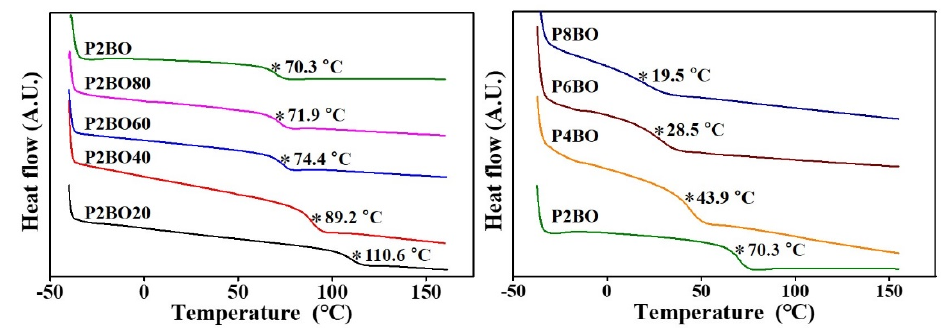
Figure 3. Differential scanning calorimetry (DSC) thermogram of P2BO# (P2BO20, P2BO40, P2BO60, and P2BO80) and PABO (P2BO, P4BO, P6BO, and P8BO) (* indicates the glass transition). Table 1. Reaction conditions and results for the synthesis of the P2BO# and PABO (P2BO, P4BO, P6BO, and P8BO).